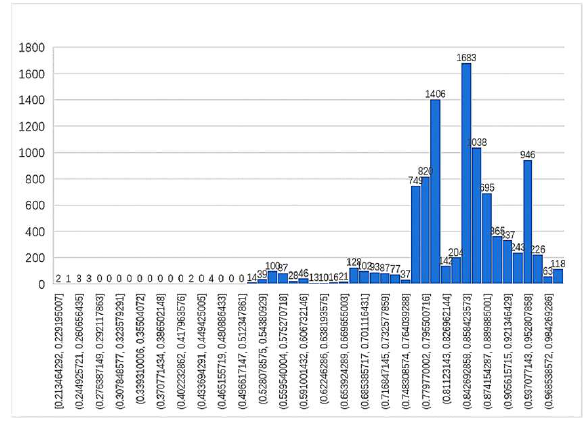
Figure 11. Distribution histogram of evaluation index values of three-word geographical names.